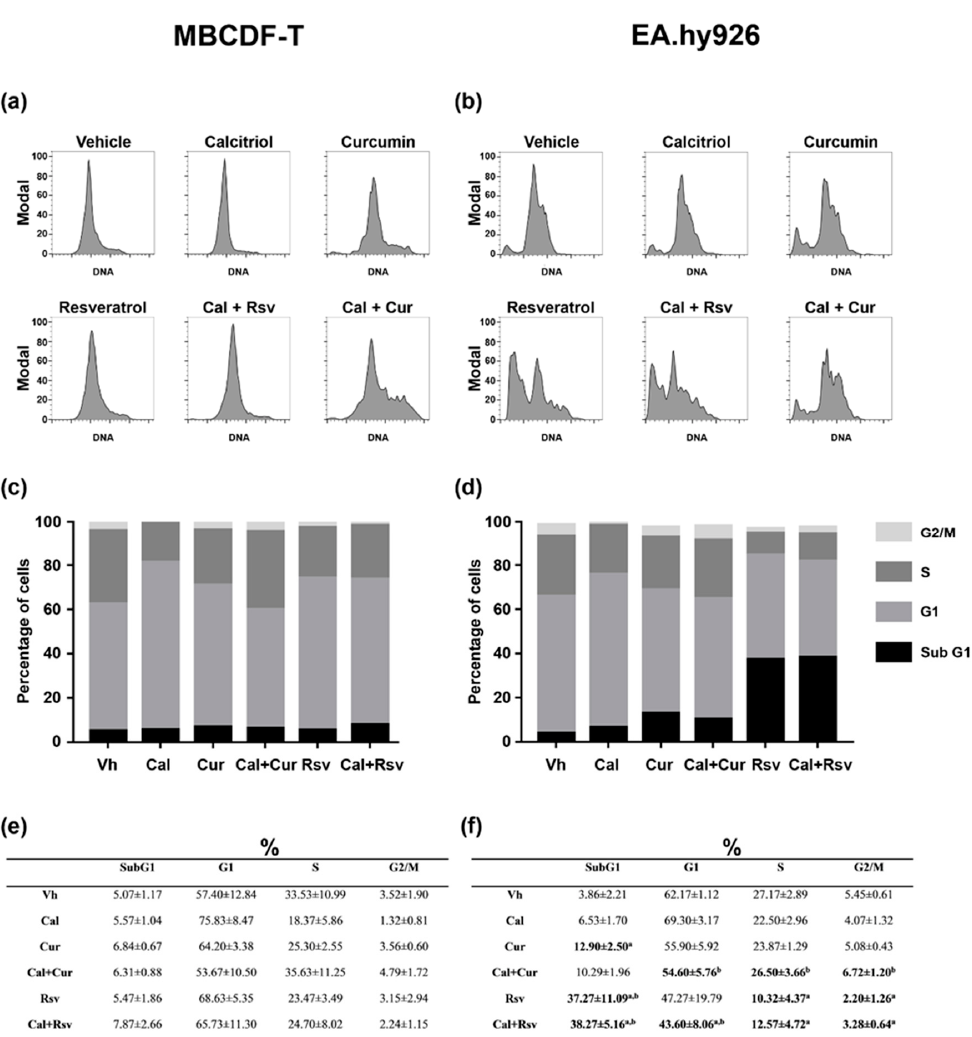
Figure 3. Effects of calcitriol, curcumin, resveratrol, and the combination of calcitriol with phytochemicals on the cell cycle. MBCDF-T ( a , c , e ) and EA.hy926 ( b , d , f ) cells were exposed to vehicle (Vh), calcitriol (Cal, 10 nM), curcumin (Cur, 10 µ M), resveratrol (Rsv, 10 µ M), or the combination of calcitriol plus curcumin (Cal + Cur) or resveratrol (Cal + Rsv) during 72 h and were analyzed by flow cytometry. Representative images per treatment are shown in ( a , b ). The percentage of cells in each cell cycle phase is depicted in the graphs ( c , d ) and in the tables ( e , f ). Results are shown as the percentage ± S.D. of cells per cell cycle phase from three independent assays. a p < 0.05 vs. vehicle-treated cells, b p < 0.05 vs. Cal (one-way ANOVA).